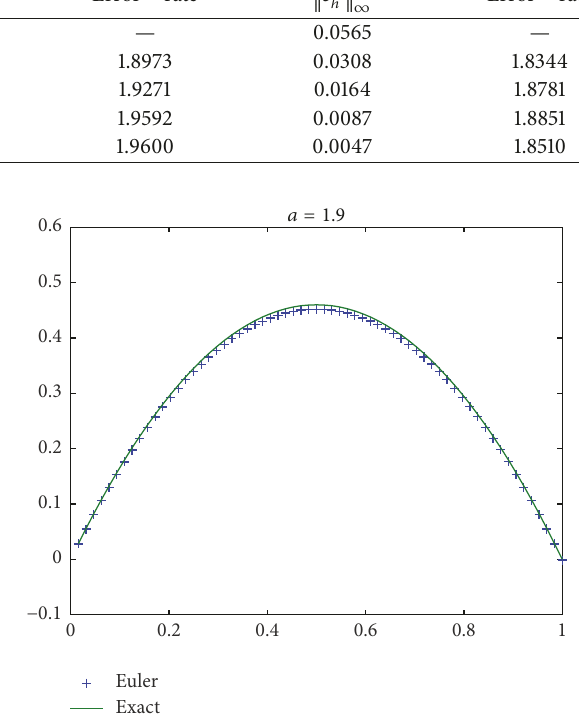
Figure 1: The behavior solution at 𝑇 = 1 with Δ𝑡 = ℎ = 2 −6 , 𝛼 = 1.9 . 2 ) requires storage of 𝑂(𝐾 and computational cost of 𝑂(𝐾